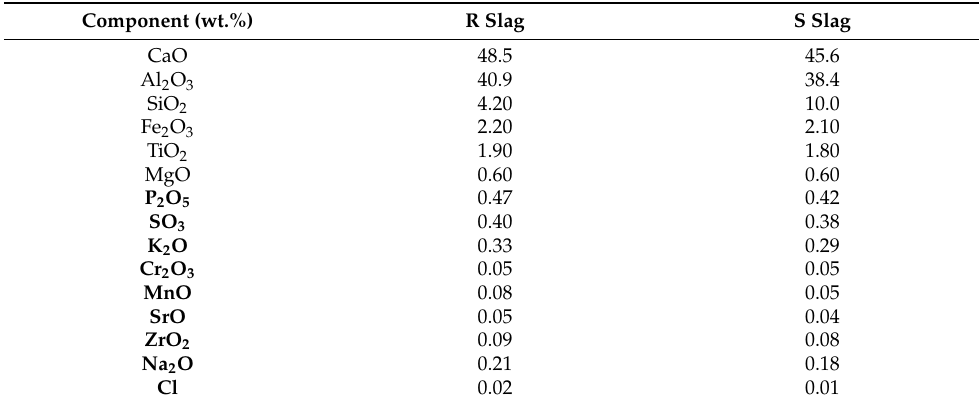
Table 1. XRF chemical composition of slags used in the study.